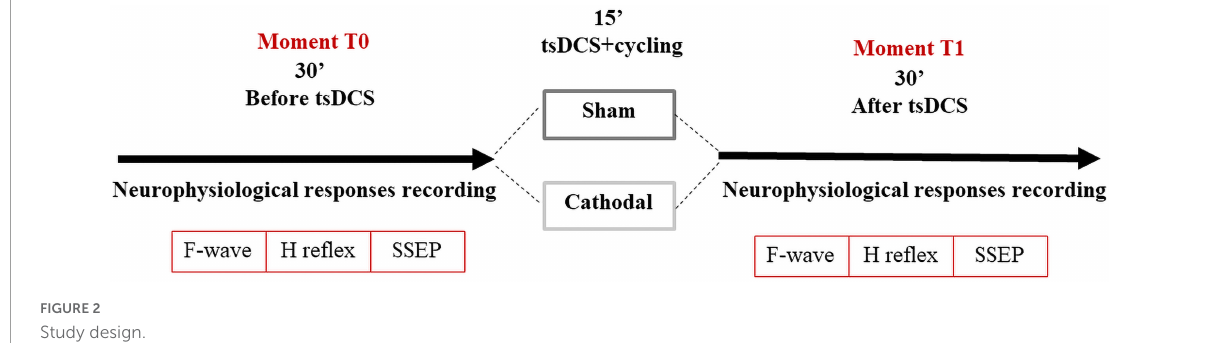
FIGURE2 Study design.